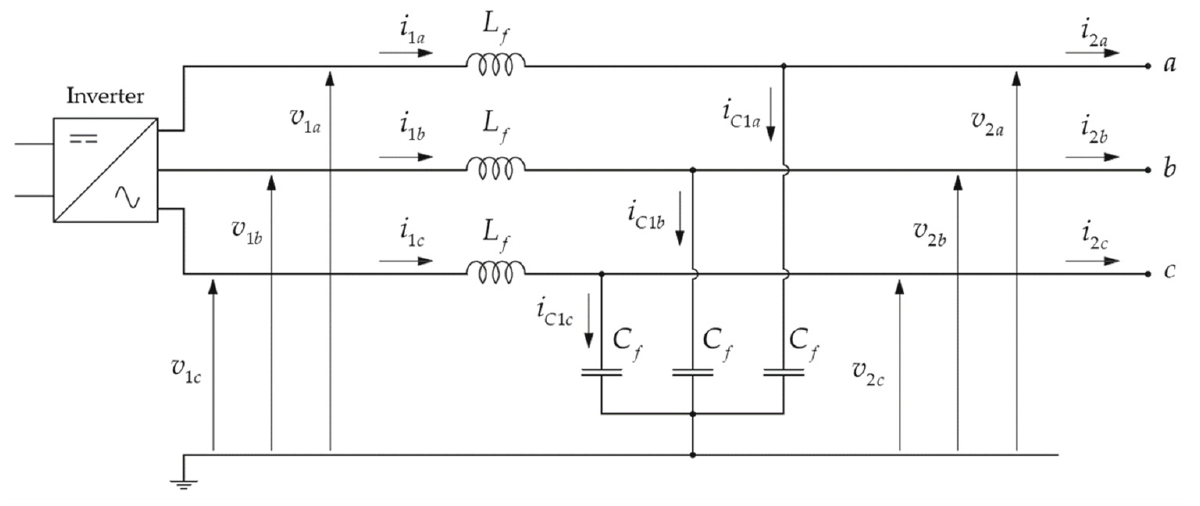
Figure 6. LC filter three-phase model.